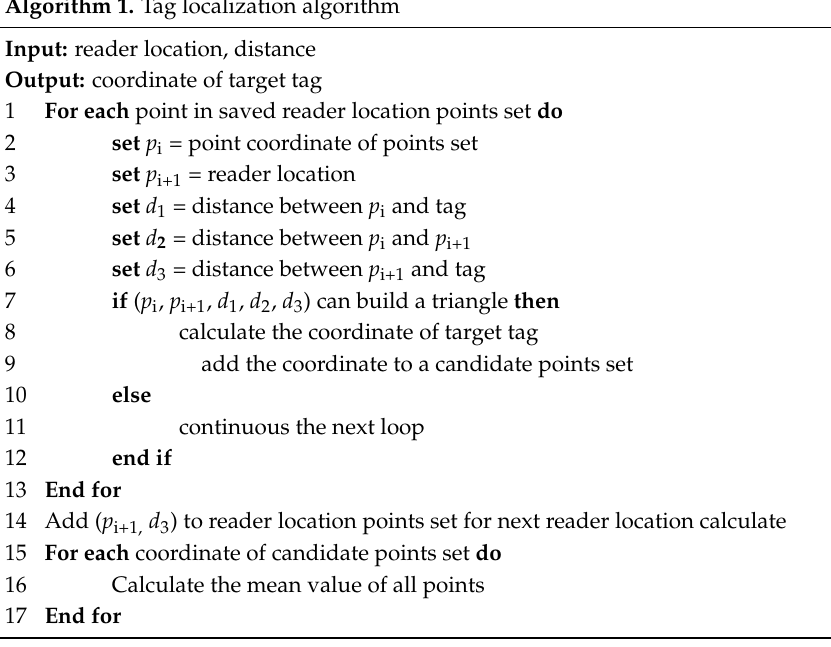
Algorithm 1: Tag localization algorithm Algorithm 1. Tag localization